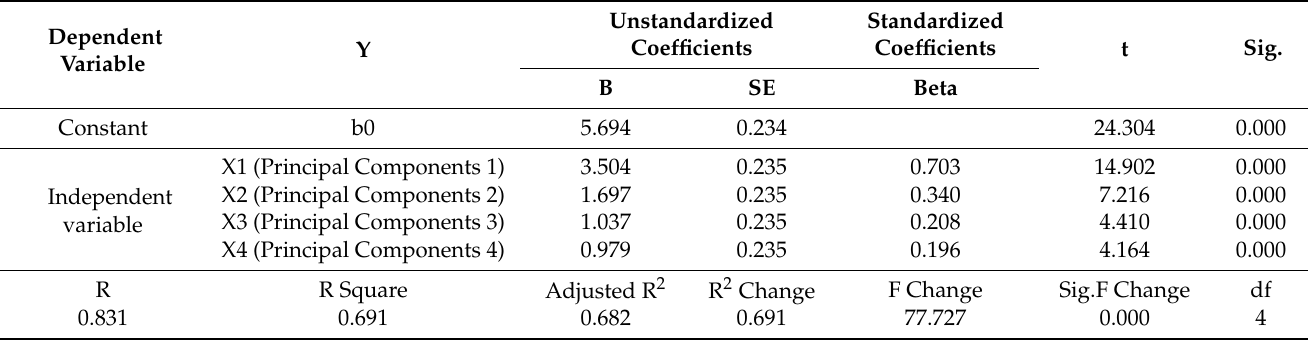
Table 7. Multiple linear regression results showing the impact of four primary components on tourists’ walking-stopping